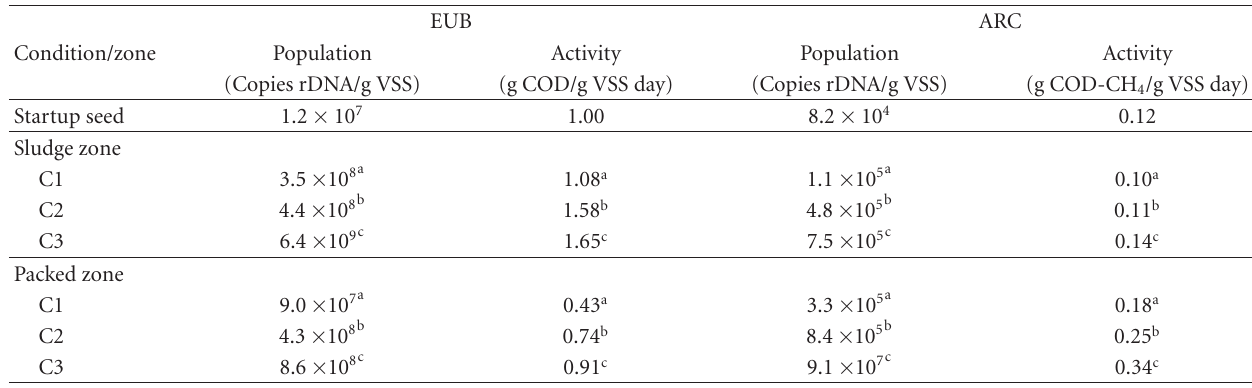
Table 4: Microbial populations and activities in startup seed, sludge, and packed zones of AHR under various operating conditions. EUB ARC